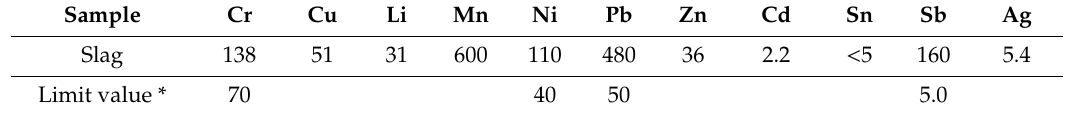
Table 3. The content of heavy metals in slag. Concentration is expressed as mg / kg. Sample